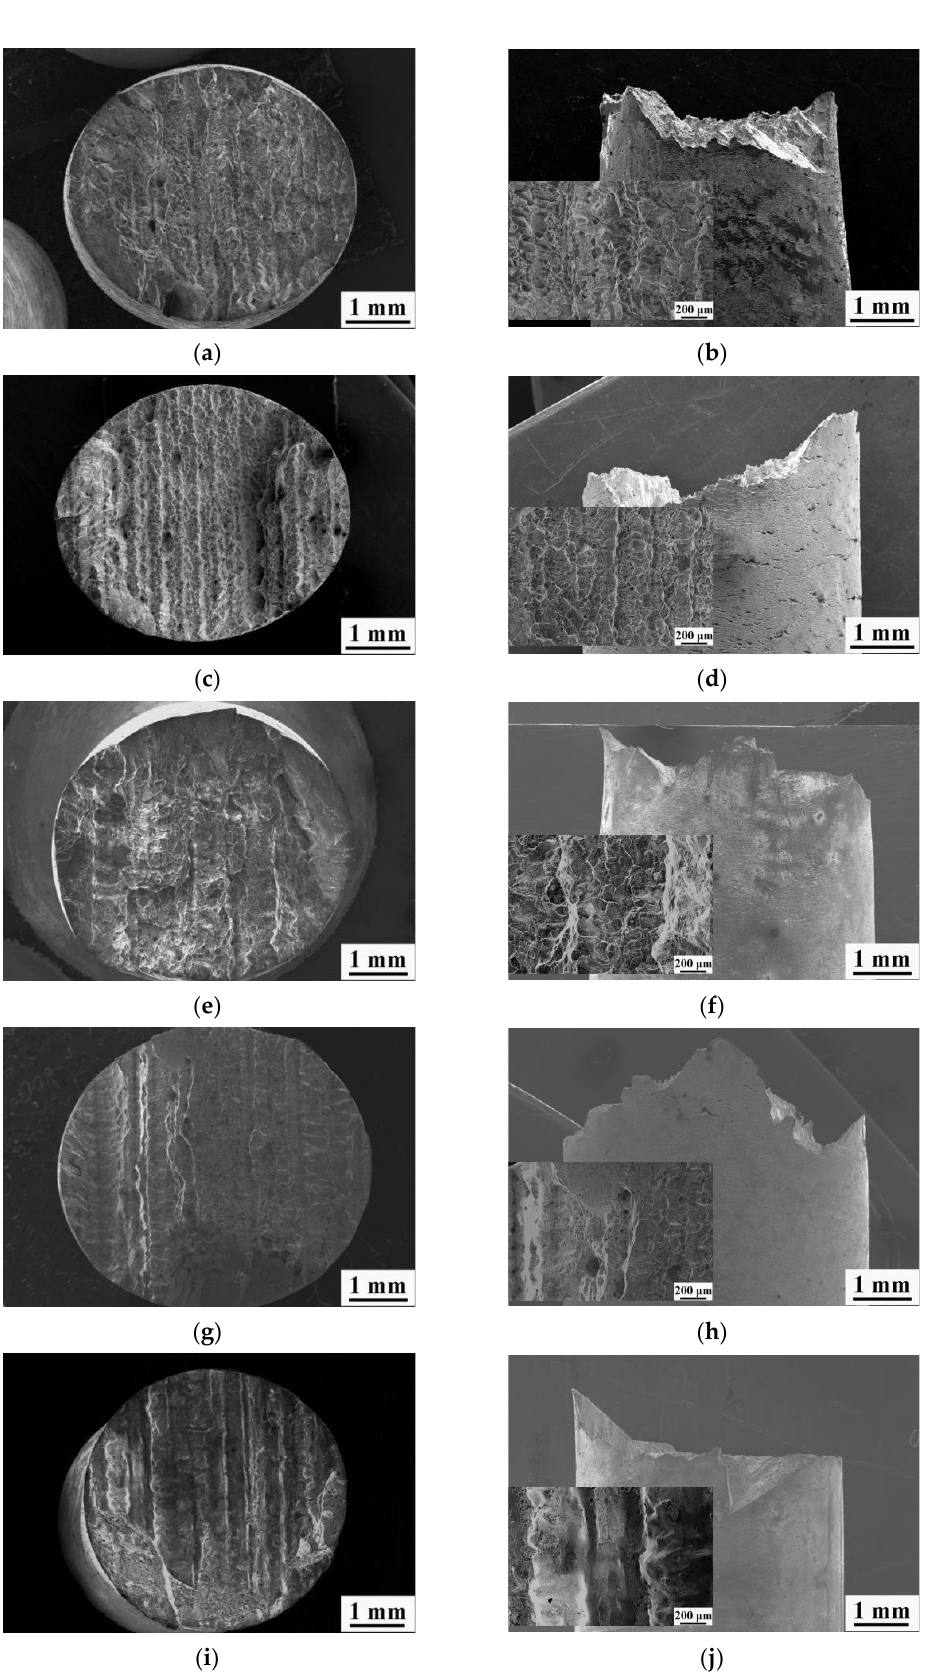
Figure 6. Tensile-fracture surfaces and longitudinal morphologies of DD9 alloy with LABs at 1100 ◦ C: ( a , b ), 3.7 ◦ ; ( c , d ), 4.8 ◦ ; ( e , f ), 6.0 ◦ ; ( g , h ), 8.9 ◦ ; ( i , j ), 11.4 ◦